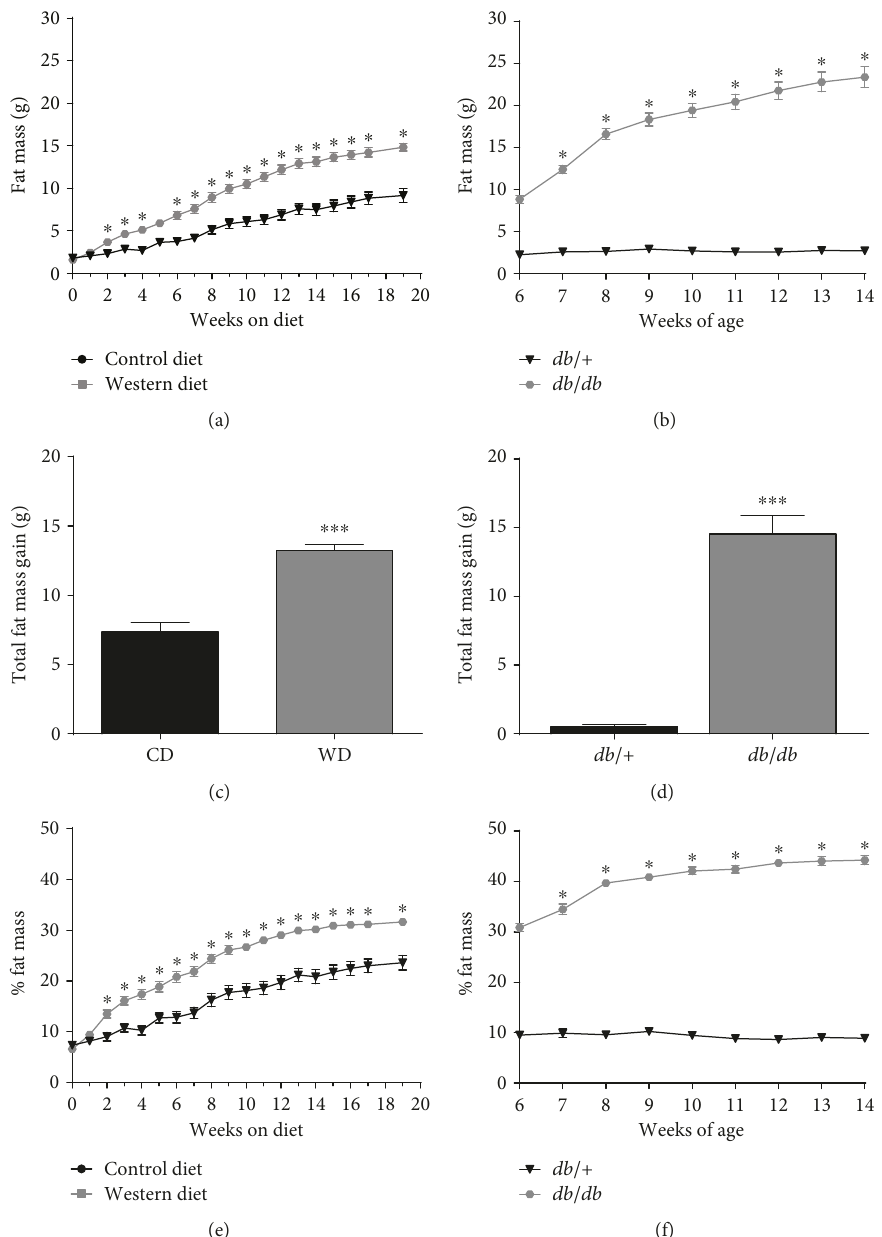
Figure 2: Increased fat mass occurs in both diet-induced and genetically driven forms of obesity. Fat mass (a) and % fat mass (e) in male C57BL/6J mice fed either control or Western diet for 20 weeks. Total fat mass gain (c) at the end of the 20-week feeding period. Fat mass (b) and % fat mass (f) in male db /+ and db / db mice between 6 and 14 weeks of age. Total fat mass gain by 14 weeks of age (d). For fat mass measurements, y -axes are set to the same scale for comparison between study groups. n = 8 per group; means ± SEM; ∗∗∗ p < 0 001 versus control; ∗ p < 0 05 versus control by repeated measures ANOVA. CD: control diet; WD: Western